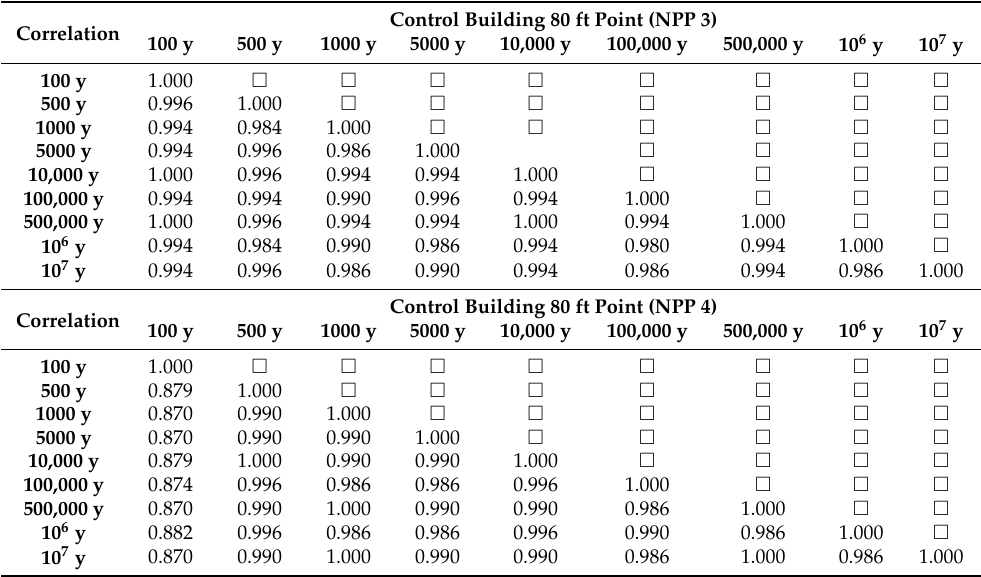
Table 12. Correlation results for maximum flood